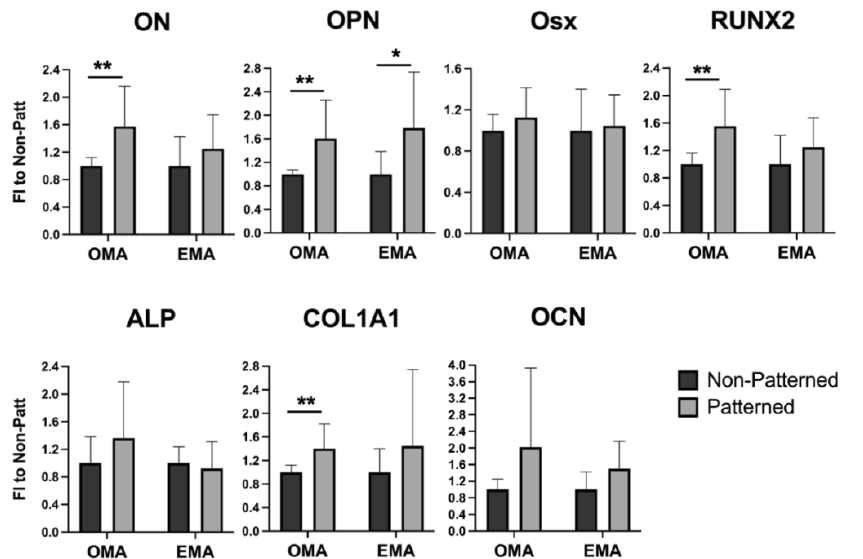
Figure 4. Expression of osteogenic genes in mMCSs organized in patterned 3-D fibrin hydrogels, cultured in either expansion degradation-free media with aprotinin (EMA),or osteogenic degradation-free media with aprotinin (OMA), quantified by qRT-PCR on day 5. Gels with randomly encapsulated cells (non-patterned) served as a negative control. * and ** represent p ≤ 0.05 and p ≤ 0.01, respectively. Genes influencing cell cycle progression, i.e., Cyclin D1, anillin (ANLN), and cysteine- rich angiogenic inducer 61 (CYR61), were also affected by patterning (Figure 5) in the osteogenic media OMA, and ANLN was also enhanced in the expansion media EMA.